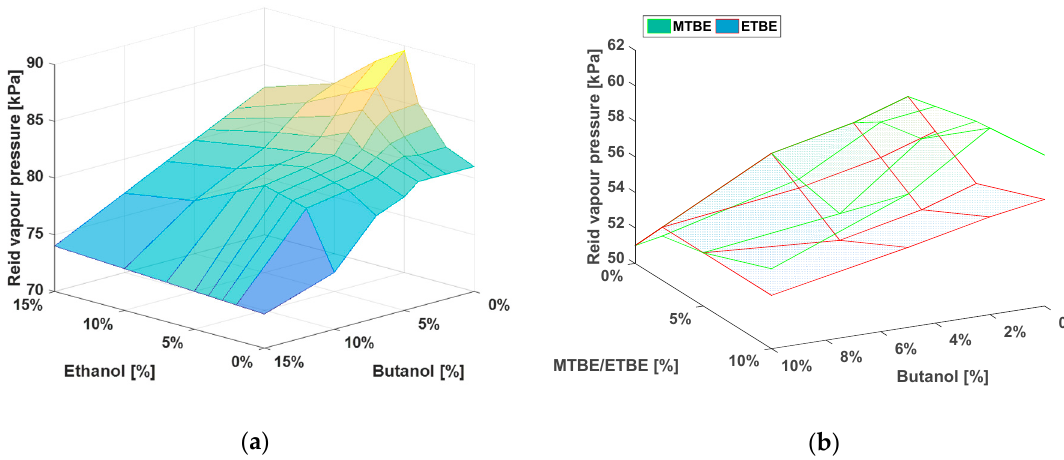
Figure 6. ( a ) Reid vapor pressure of winter gasoline mixtures depending on the volume and type of added alcohol; ( b ) Reid vapor pressure of a summer gasoline with n-butanol, MTBE, and ETBE.